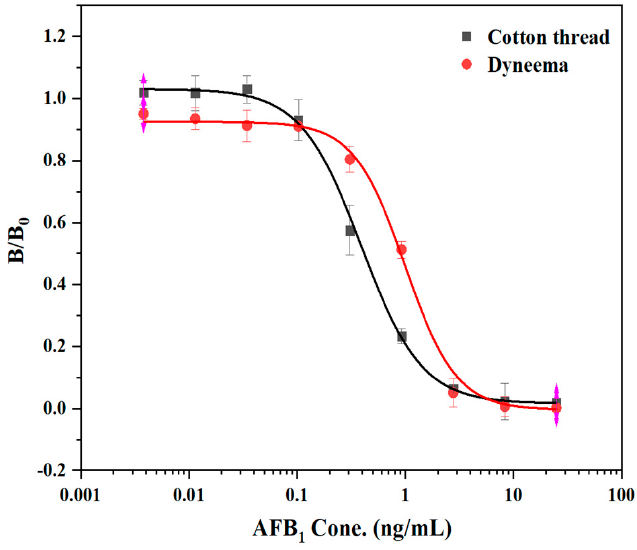
Figure 4. Competitive standard curve of mAb against AFB 1 on different materials.